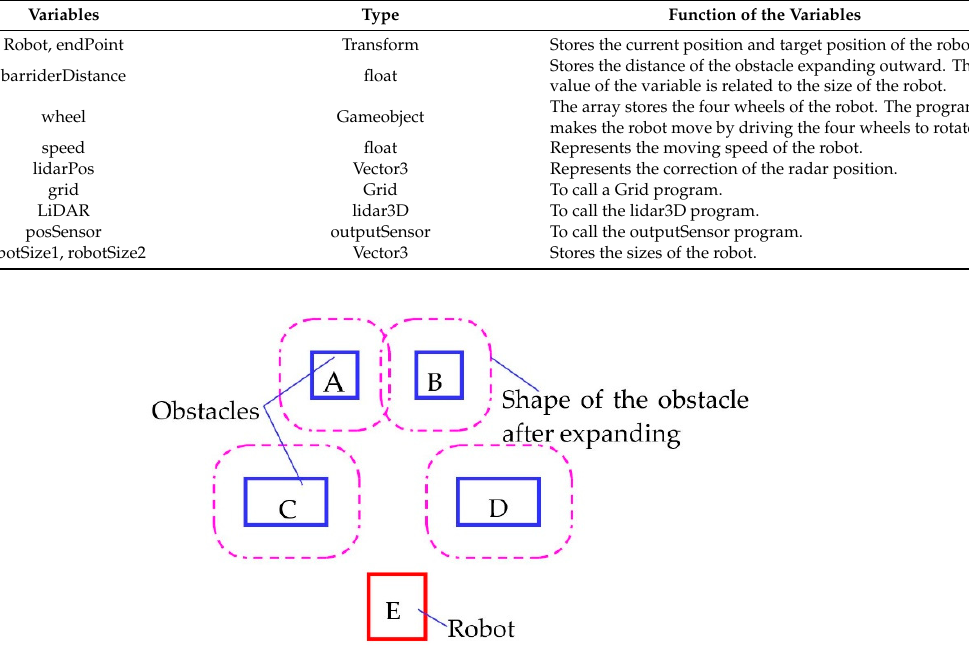
Figure 18. Schematic diagram of obstacle expansion.